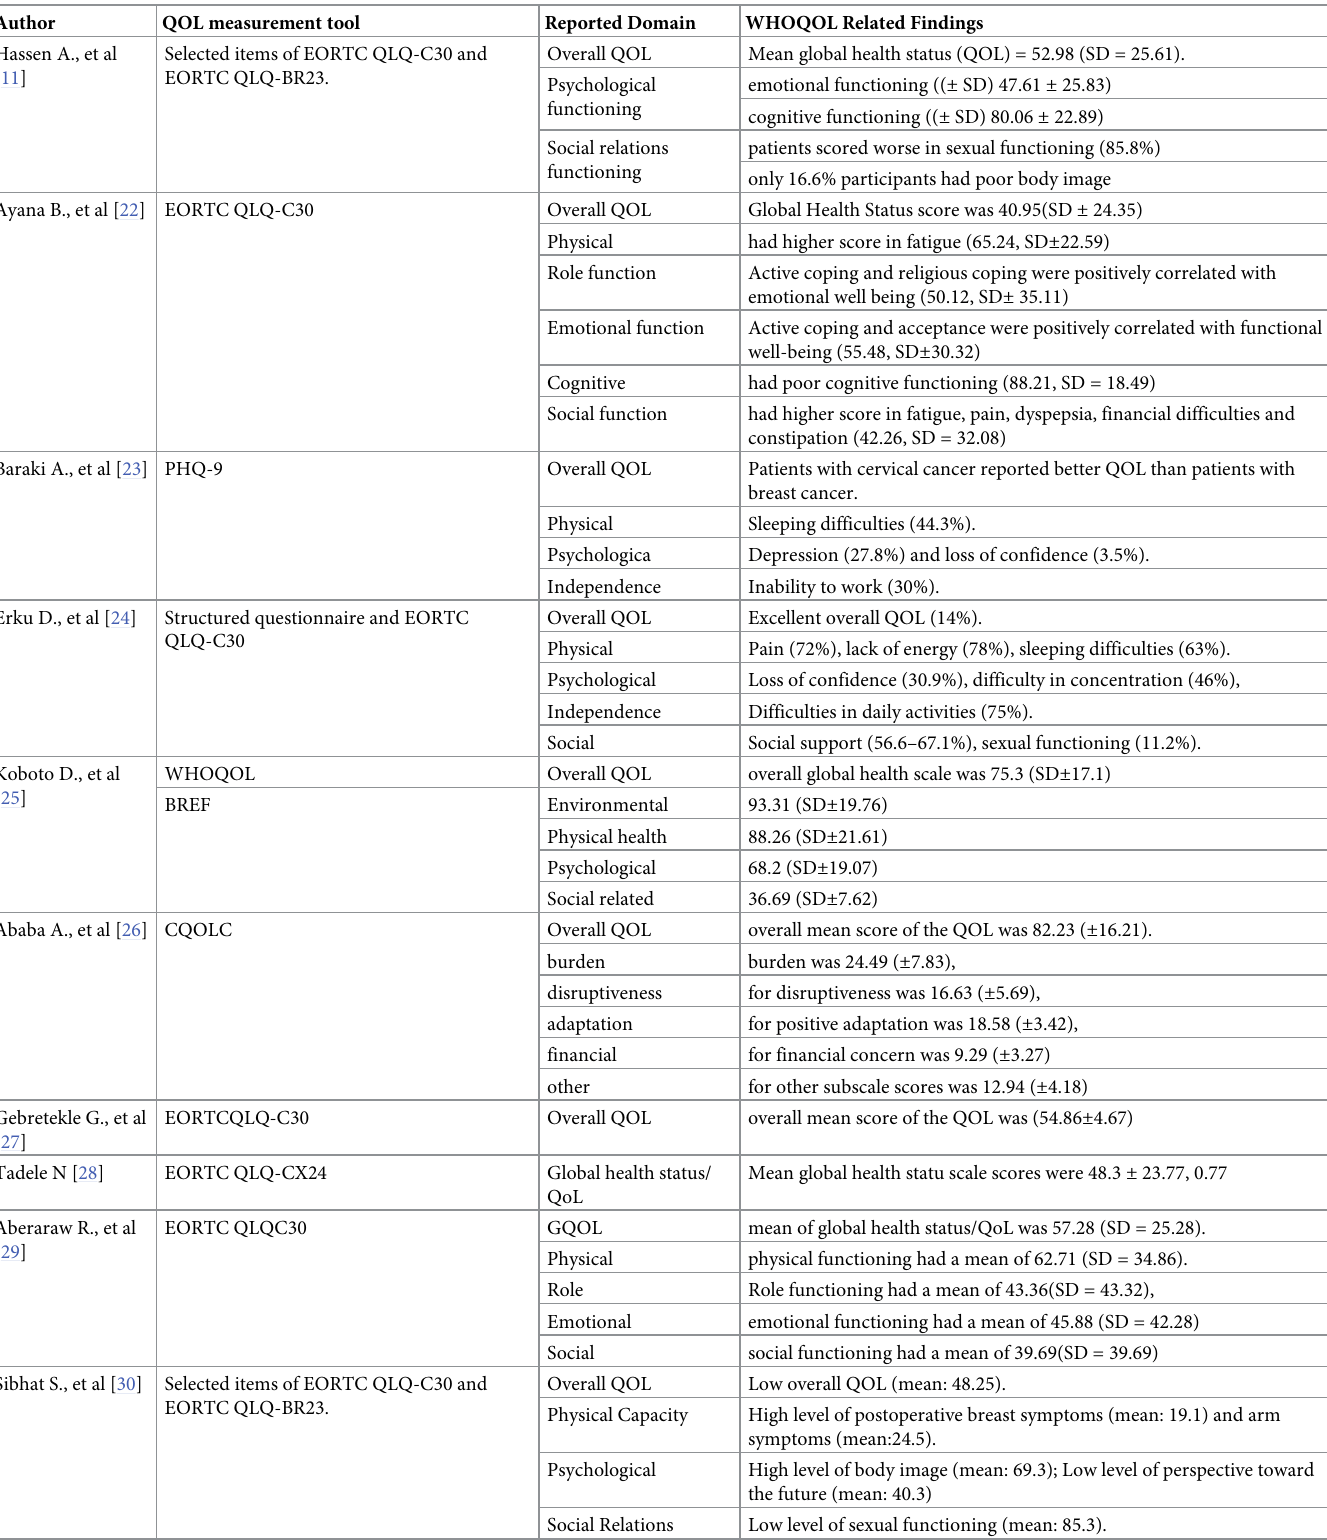
Table 3. WHOQOL related finding of quality of life among cancer patients in